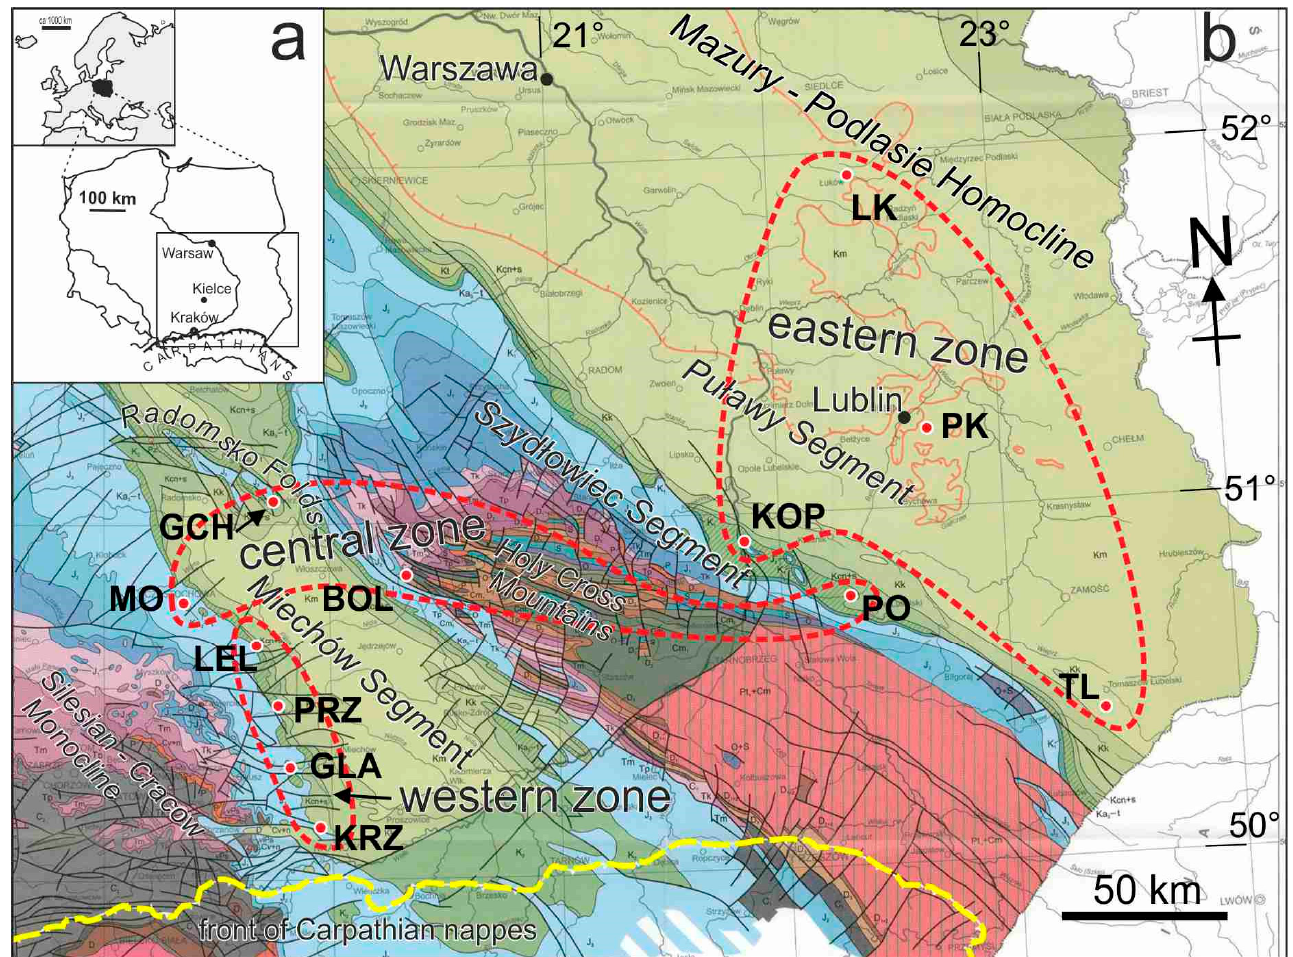
Figure 2. Geological map of the south-eastern part of Poland. ( a ) Location of study area in Poland and Europe; ( b ) geological map after [40] with standard stratigraphic colours used: green—Cretaceous; blue—Jurassic; violet–pink—Triassic; other colours—pre-Mesozoic. Red dots indicate sample localities; the western zone: KRZ—Korzkiew, GLA—Glanów-Stroniczki, PRZ—Przychdy, LEL—Lelów; the central zone: MO—Mokrzesz, GCH—Che ł mo Mount, BOL—Bolmin, PO—Potok IG-1; the eastern zone): TL—Tomaszów Lubeski IG-1, PK—Piaski IG-2, KOP—Kopiec, LK— Ł uków IG-1. Yellow dotted line shows front of the Carpathian nappes. The division of the study area into individual zones was made on the basis of the results of rutile mineralogical studies, which allowed to distinguish three distinct groups (western, eastern, and central) of rutile grains crystallizing at different temperatures (more detailed description in the text). Table 1. GPS coordinates of the examined localities.